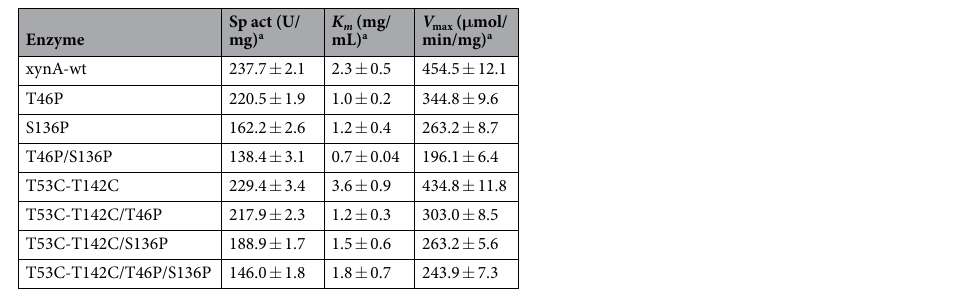
Table 5. Specific activity and kinetics of wild-type xylanase and its mutants. a Values are means ± standard deviation. Sp act: Specific